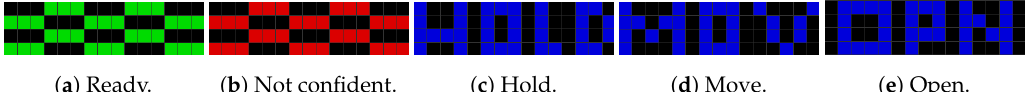
Figure 13. LED patterns used by the robot to communicate with the user using the robot’s armband. ( a ) Green pattern used to indicate when the robot is ready for physical interaction. ( b ) Red pattern indicating low classification confidence (<70%). Textual patterns showing the state of the robot when user intents are identified with high confidence: ( c ) “hold” (polish intent), ( d ) “move” (move intent), and ( e ) “open” (grab intent). The character “e” could not be expressed due to the four row armband matrix restriction. Algorithm 1: Finite state machine of the control of the robot during the validation. Data: Force sensor’s